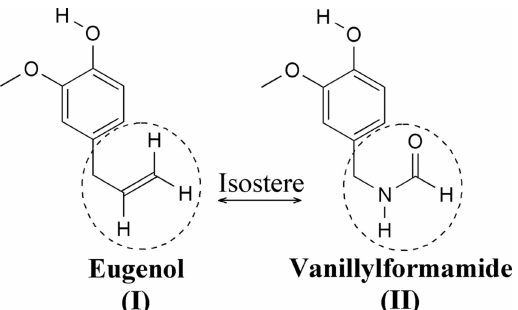
Figure 1 Eugenol ( I ) and the title compound ( II